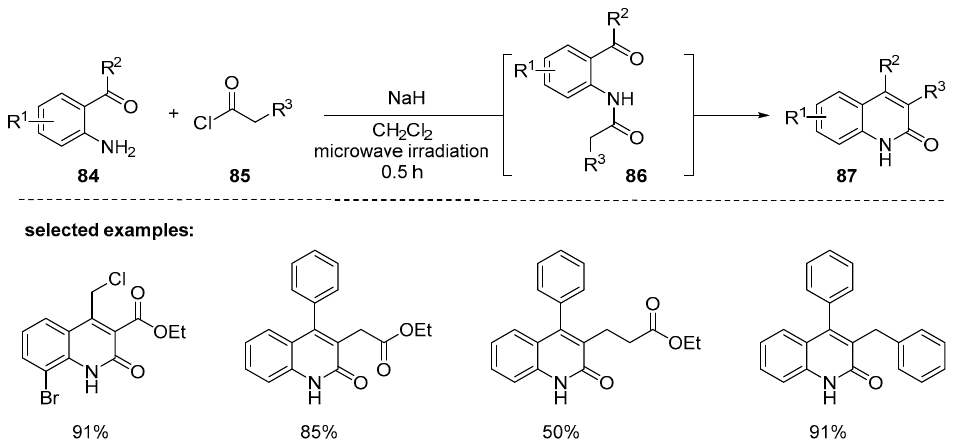
Scheme 25. Synthesis of 3,4-disubstituted 2-quinolones by one-pot condensation promoted by microwave